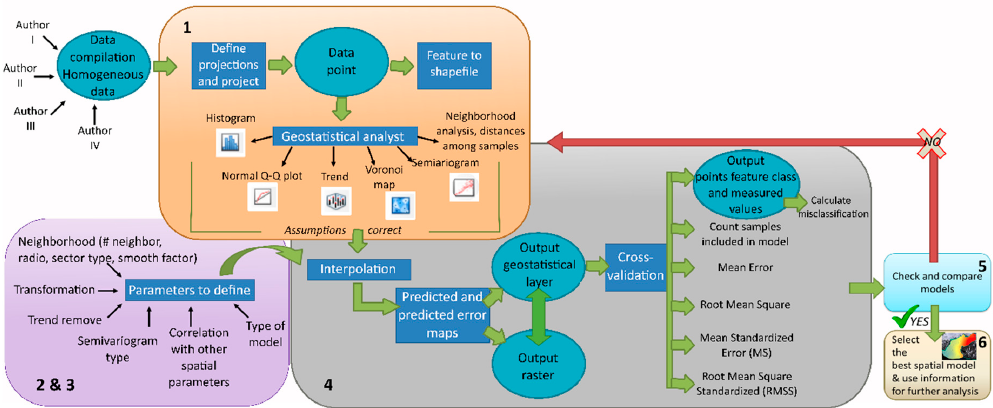
Figure 2. Detailed workflow for geostatistical studies and building a spatial model from step 1 to 6. The arrows in color show the workflow of the different processes (in boxes) to apply an accurate geostatistical model. In the circles are the outputs to be spatially georeferenced into a shapefile. The black arrows that come out of a process box indicate a result, while when they point to the process, it means input for the application .